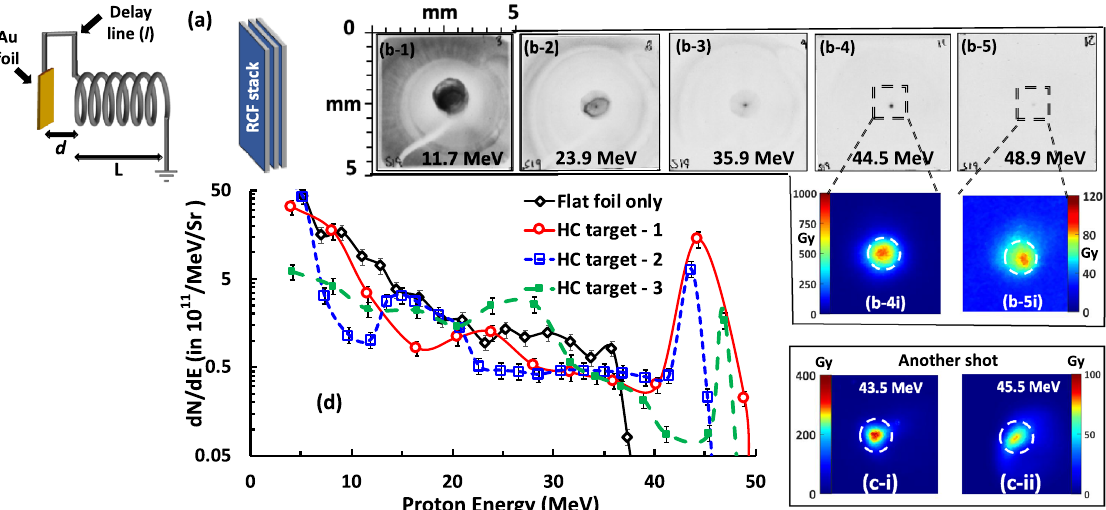
Figure 1. (a) Schematic of the setup (not to scale) used in the experiment. The HCs were made of 0.125 mm thick stainless steel wire and had pitch, internal diameter and length of 0.7 ± 0.025 mm , 0.7 ± 0.015 mm and 7.7 ± 0.1mm respectively. The HC was placed at 1.5 ± 0.05mm from a ∼ 10 µ m gold (Au) foil and connected to the foil by a delay line of length 6 ± 0.1mm . The Radiochromic films (RCF) stack detector was placed at 60 ± 1mm from the interaction foil. Proton beam footprints captured by different RCF layers in the stack, corresponding to different proton energies, are shown in (b-1) - (b-5) . The scale shown at the top right corner of (b-3) refers to the RCF plane. Zoomed-in views of the dose profiles for the high energy pencil beams are shown in (b-4i) , (b-5i) , (c-i) and (c-ii) , where the last two snapshots are obtained from a second shot during the campaign using very similar laser and target parameters. The white-dashed circles on the zoomed-in views corresponds to the internal diameter of the HC. (d) shows the comparison between a typical proton spectrum obtained from reference flat foil targets and three HC target shots, RCF images from two of which (labelled as HC target-1 and HC target-2, respectively) are shown in (b,c) . The spectrum labelled as HC target-3 was obtained from a shot taken at similar interaction conditions, using a HC target syncing similar energy protons ( ∼ 30 MeV) as in case of (b,c) with an internal diameter and pitch of 0.5 ± 0.015 mm and 0.5 ± 0.02mm respectively. The on-axis proton spectra were obtained from the RCF data, as described in refs. 22,28 , considering the proton dose from the area enclosed by the black-dashed circles in the zoomed-in RCF views, corresponding 4 sr to 0.33 ◦ half angle divergence ( 10 − ). The error bars were estimated considering the error in dose conversion 22 and uncertainties in background